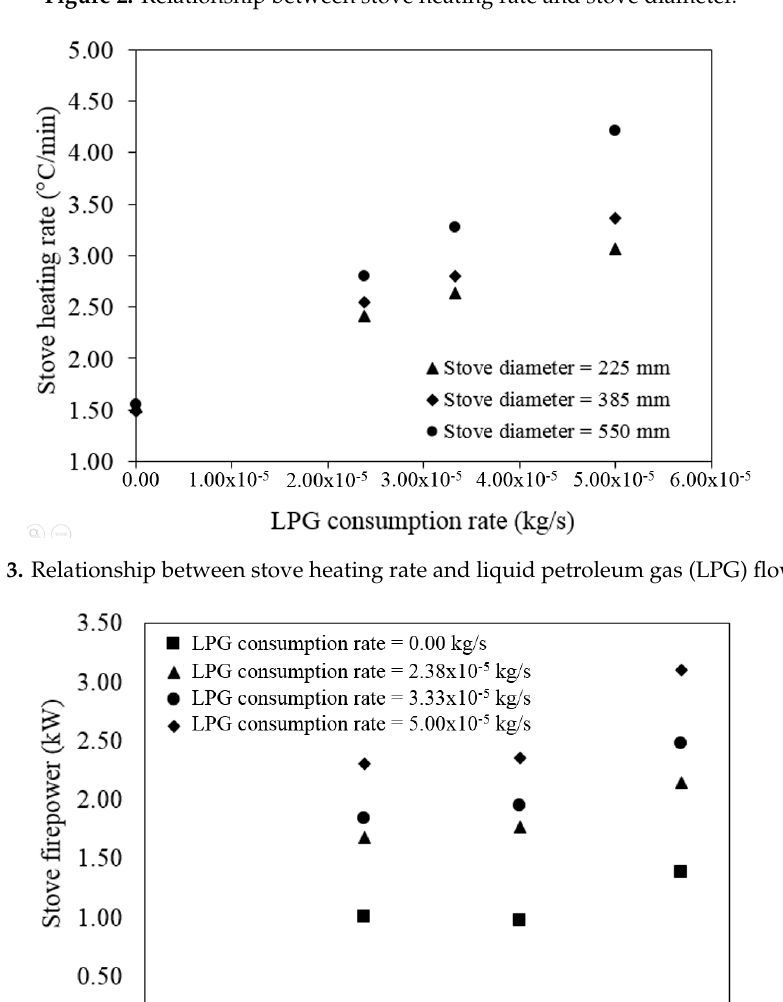
Figure 5. Relationship between firepower and LPG flow rate.